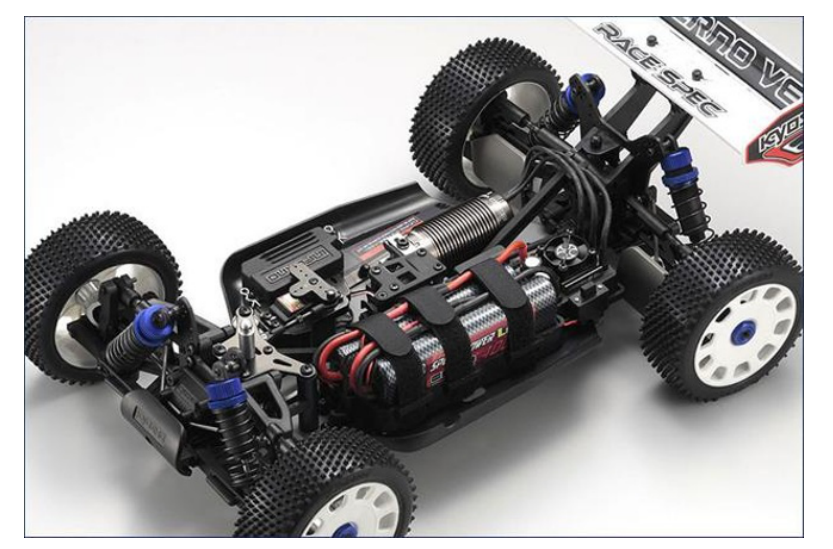
Fig. 2. Basic radio-controlled